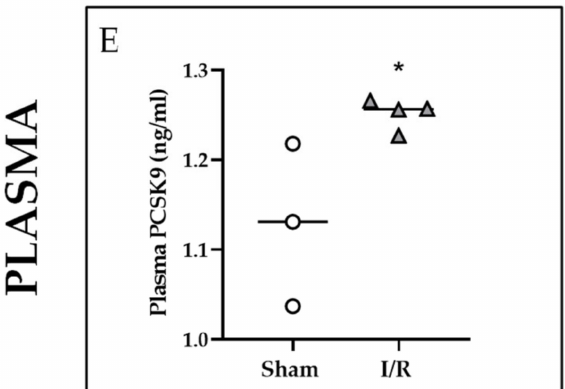
Figure 3. Analysis of Mstn and PCSK9 after sham intervention or ischemia/reperfusion (I/R, 30 min/24 h) in kidneys. ( A ) Mstn mRNA expression by quantitative real-time PCR. The results have been normalized by expressing the number of transcript copies as a ratio to β 2-microglobulin ( β 2-m) and indicated as fold changes (FC) in respect to kidneys from sham- operated rat (#15) (left); * p < 0.05. ( B ) Immunostaining: in representative images, arrows indicate sites of intense positivity in tubular cells (left); image analysis quantification (right); ** p < 0.01. ( C ) PCSK9 mRNA expression by quantitative real-time PCR. The results have been normalized by expressing the number of transcript copies as a ratio to β 2-microglobulin ( β 2-m) and indicated as fold changes (FC) in comparison to kidneys from sham-operated rat (#15) (left); * p < 0.05. ( D ) Representative images of immunohistochemistry (left) and image analysis quantification (right); * p < 0.05. ( E ) PCSK9 level in rat plasma by enzyme linked immunosorbent assay; * p <